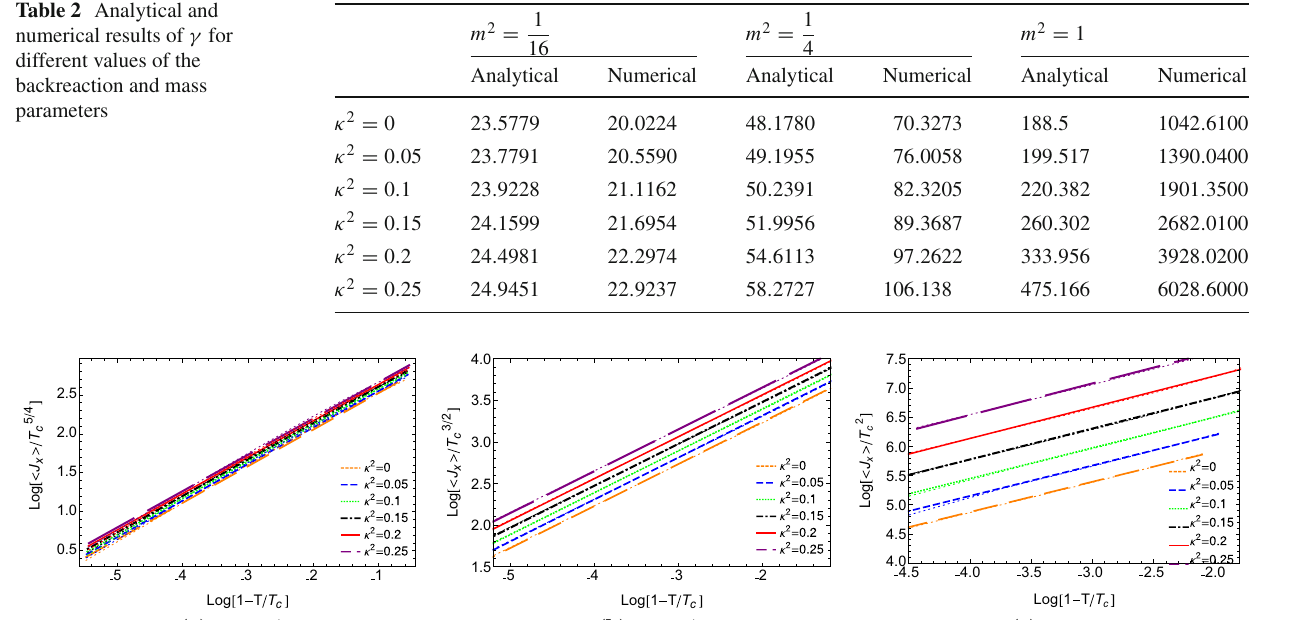
Table 2 Analytical and numerical results of γ for different values of the backreaction and mass parameters